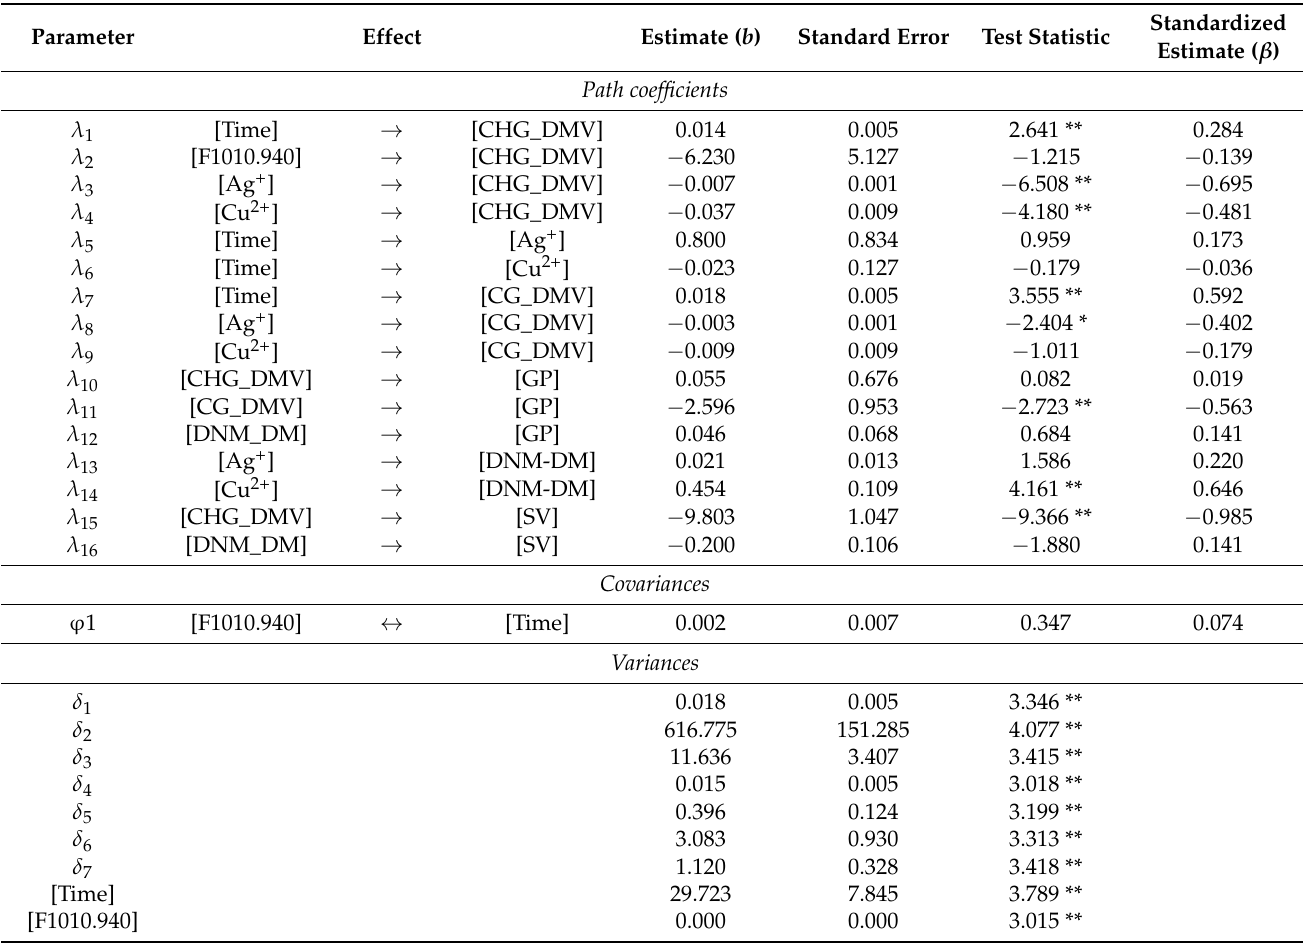
Table 4. Path coefficients, variances and covariances for the analyzed